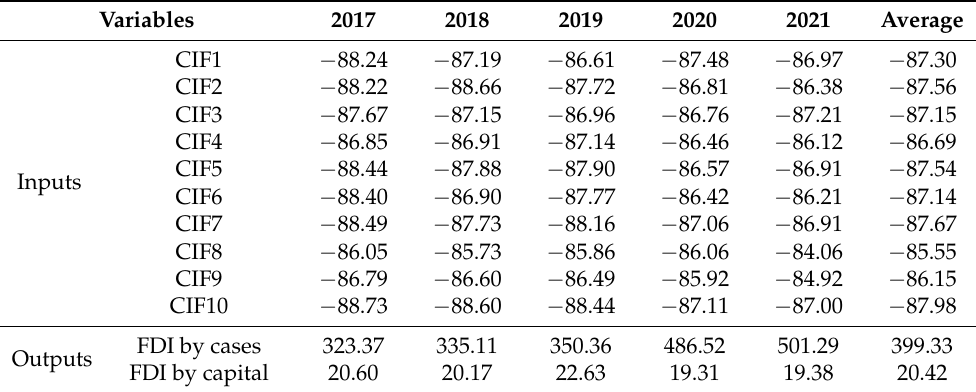
Table 6. Input-output projection rate (%) of provinces’ FDI efficiency over the years.